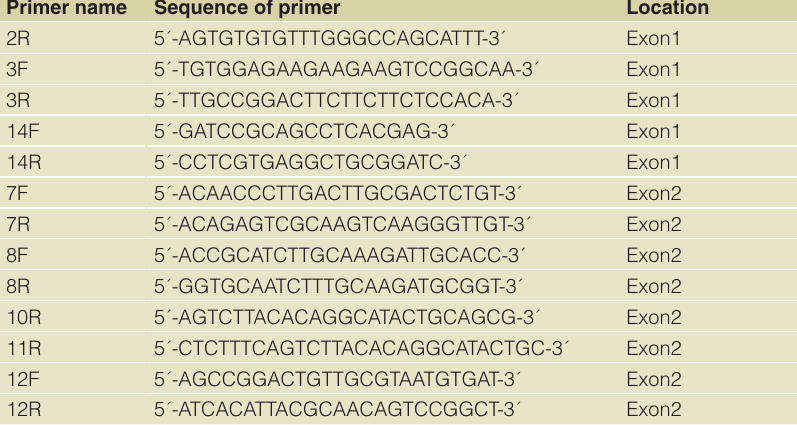
Table 2. List of GUN4 specific primers. These primers were used for GUN4 (Cre05.g246800) genomic DNA PCR on 6F14 and 4A+ and also for DNA sequencing to generate the data in Figure S3 and Figure S4.